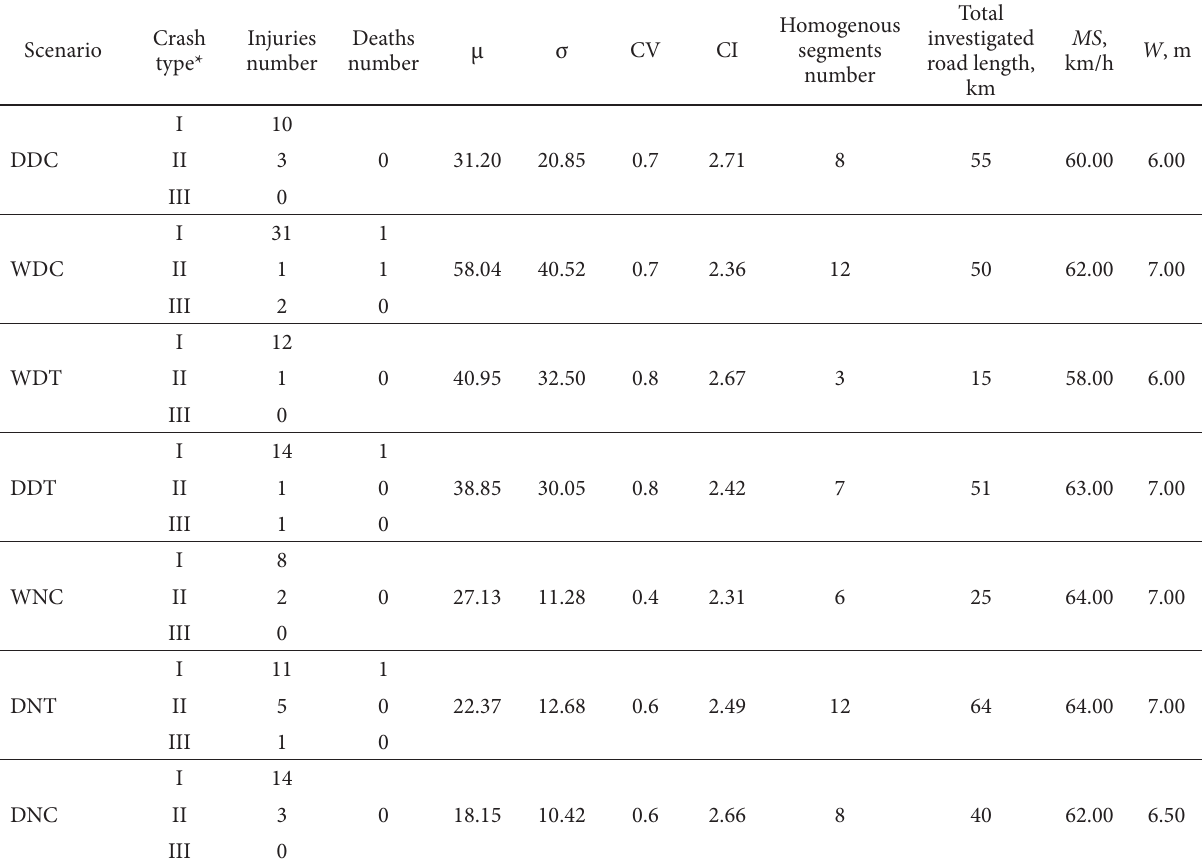
table 2. Descriptive statistics of crashes analyzed in 2003−2007 Crash Scenario